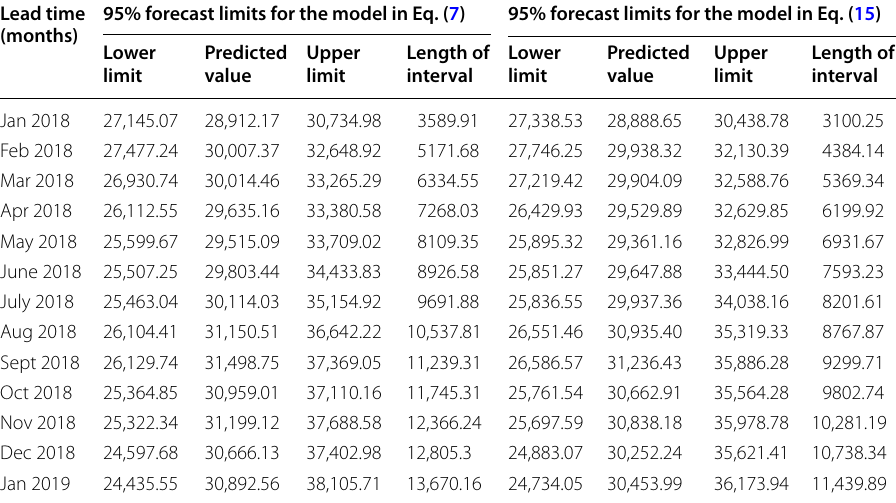
Table 5. 95% Forecast limits for predicted future values for model in Eq. (7) and model in Eq. (15) Lead time 95% forecast limits for the model in Eq. (7) 95% forecast limits for the model in Eq. (15) (months) Lower Predicted Upper Length of Lower limit value limit interval